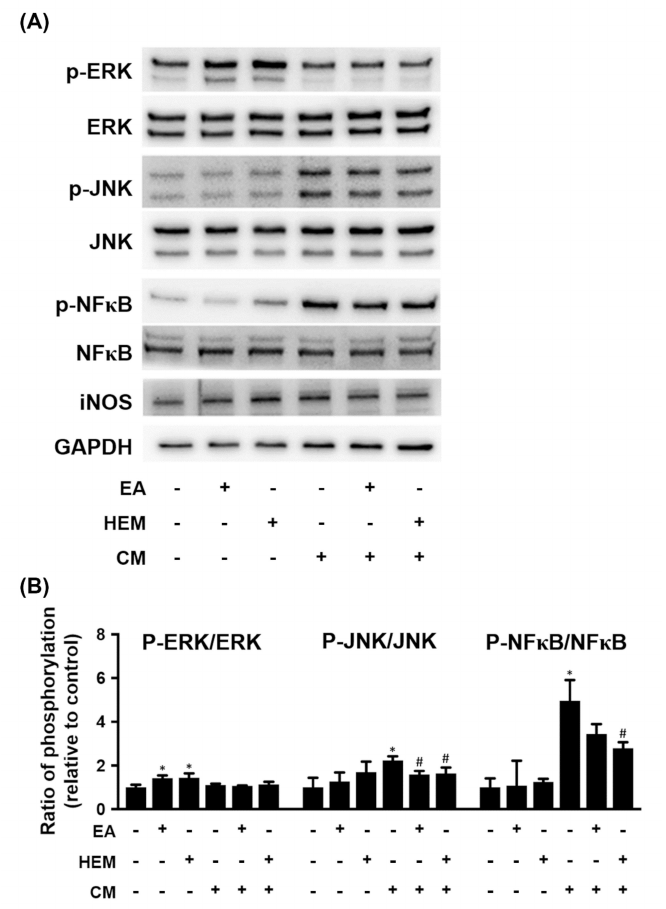
Figure 6. Effect of EA or HEM on signaling molecules from microglia-mediated neurotoxicity. The cul- ture conditions of the N2a cells are shown in Figure 7. ( A ) The protein levels of ERK 1/2, JNK, NF- κ B and iNOS were detected in N2a cells by western blot ( n = 3). GAPDH was used as a loading control. ( B ) Quantitative densitometry was used to calculate the phosphorylation ratios of p-ERK to ERK, p-JNK to JNK and p-NF- κ B to NF- κ B, which were normalized to the control. The relative density was estimated by NIH ImageJ densitometric analysis. The results are expressed as the mean ± SD. * p <